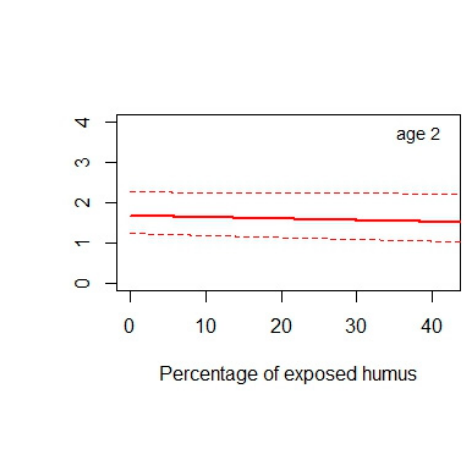
11% exposed humus. The prediction line for ( b ) is based on an average contribution of the effect of level of